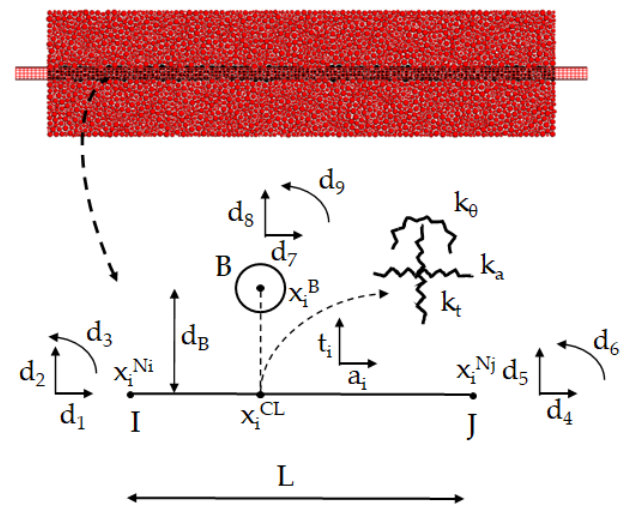
Figure 3. Steel bar-particle contact interface